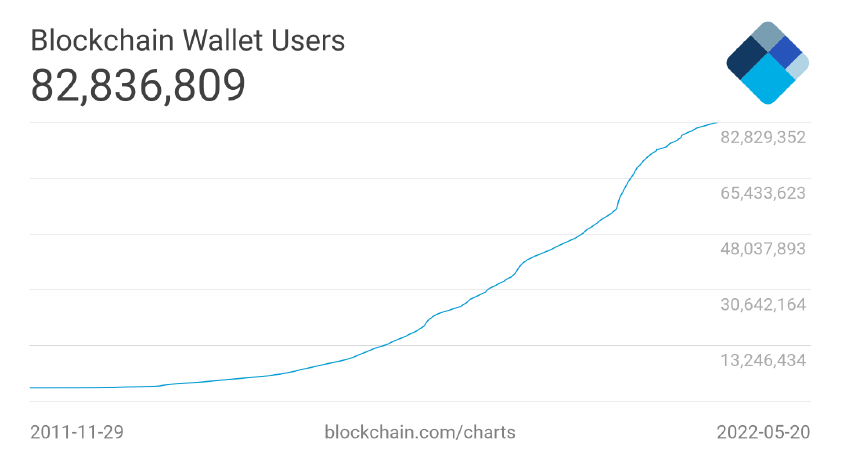
Figure 2. Blockchain.com chart of the number of unique wallets created over the years